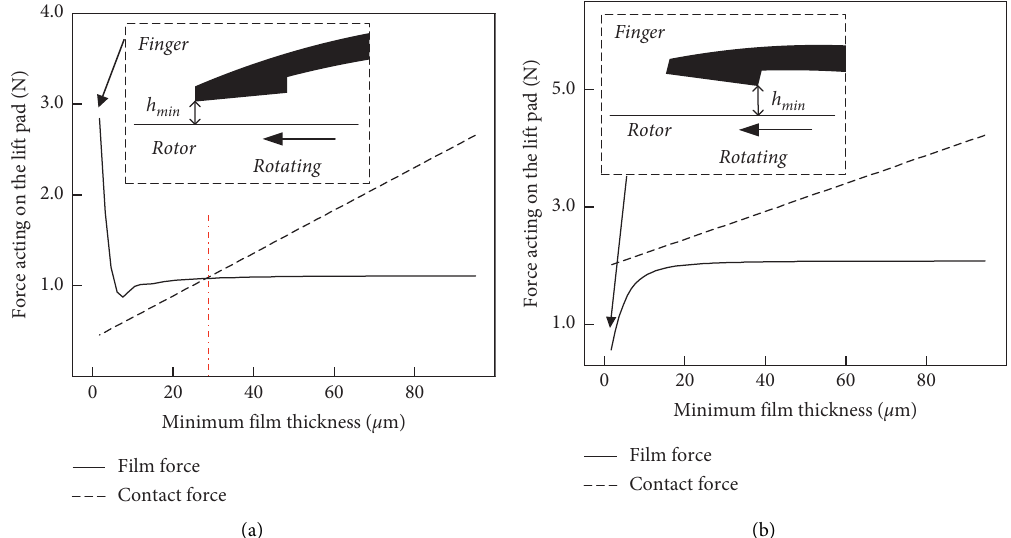
Figure 8: Relationship between the minimum film thickness and the film force. (a) The finger does not contact the rotor. (b) The finger contacts the rotor.